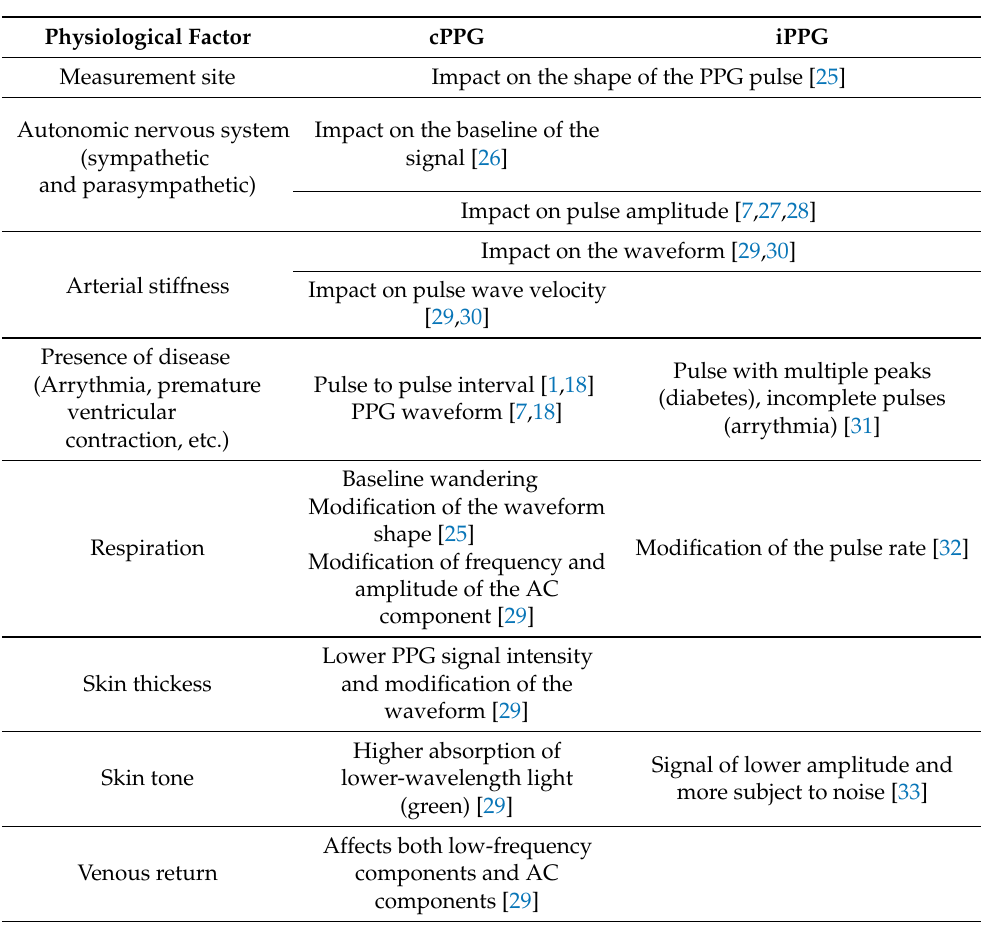
Table 2. Physiological factors affecting a PPG